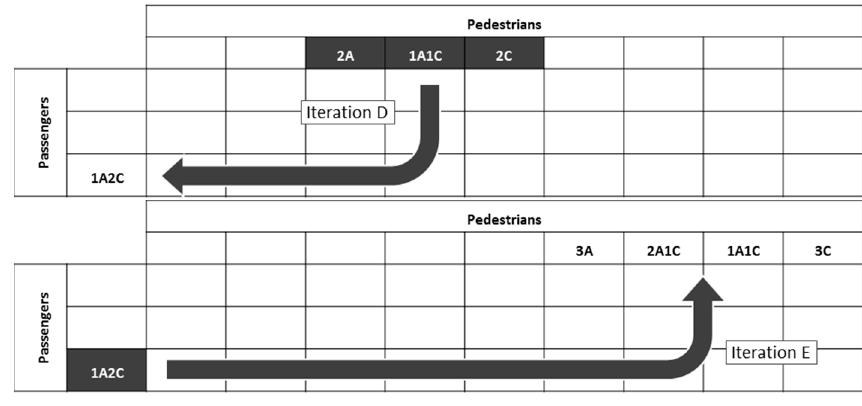
Figure 2. Method for calculating scenario absolute values.